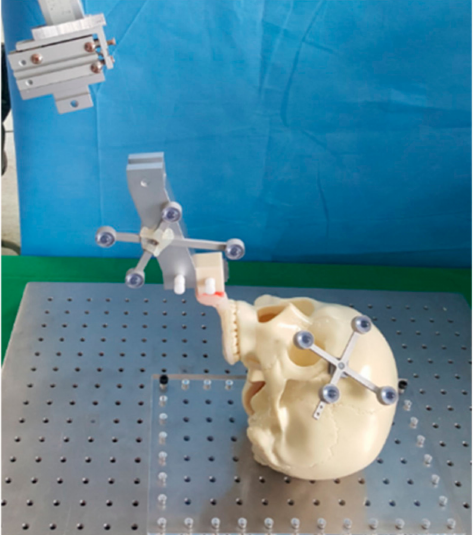
Figure 3. Intraoperative initial registration.